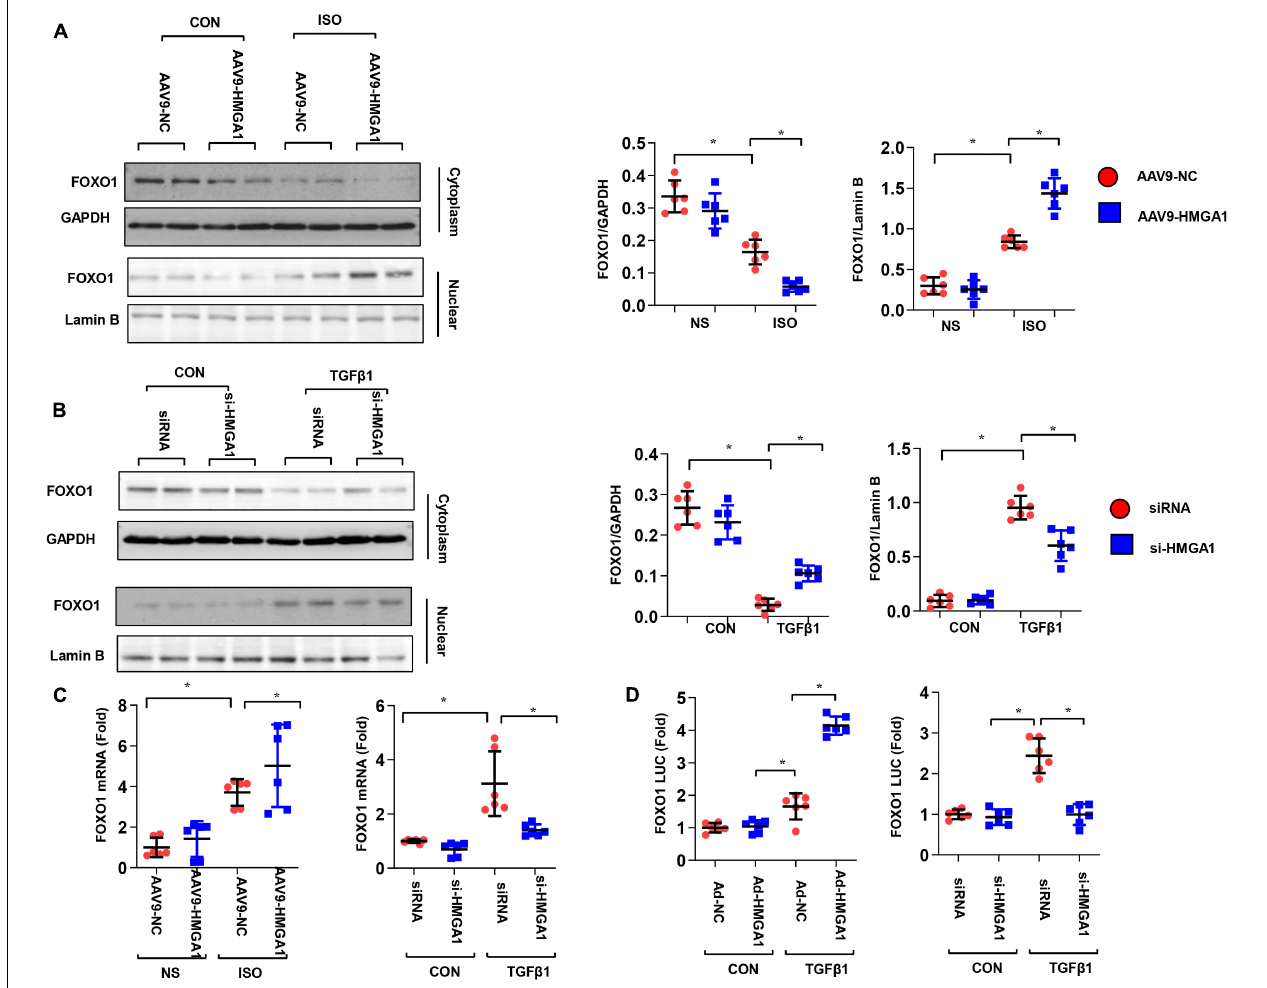
FIGURE 5 | High-mobility group A1 (HMGA1) modulated the expression and phosphorylation of FOXO1. (A) The protein level of FOXO1 in heart tissue after AAV9-HMGA1 and ISO injection ( n = 6). (B) The protein level of FOXO1 in CFs after HMGA1 siRNA and TGF β 1 treatment ( n = 6). (C) The mRNA level of FOXO1 in heart tissue (left) and CFs (right) in each group ( n = 6). (D) Luciferase reporter results in CFs with HMGA1 overexpression or HMGA1 silencing. * p <